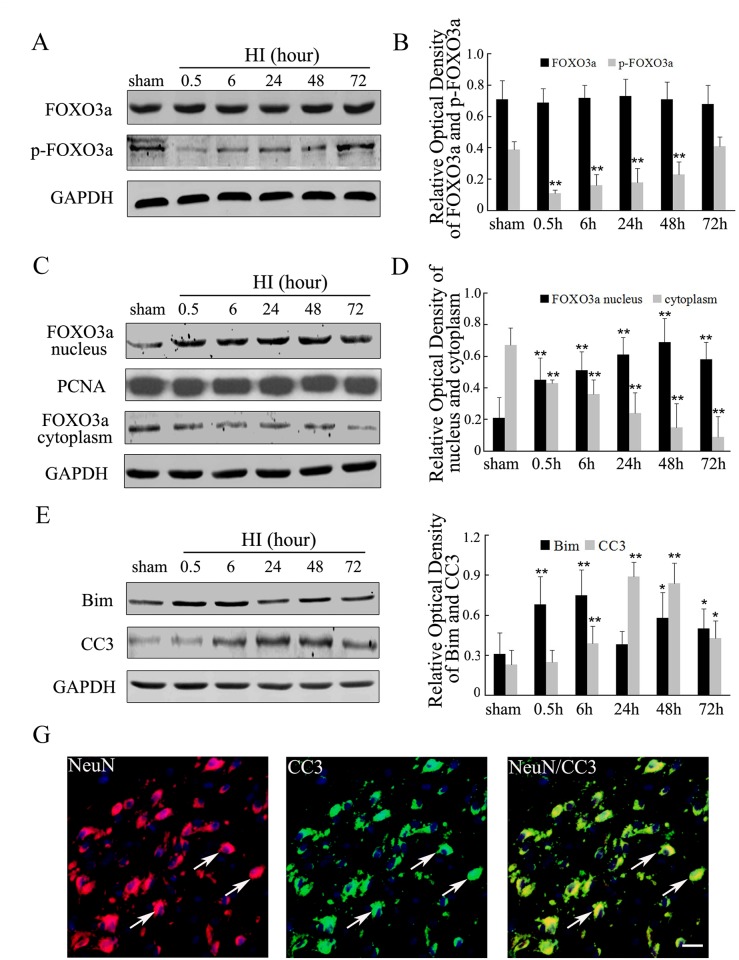
HI promotes FOXO3a dephosphorylation, which induces FOXO3a translocation into the nucleus and upregulates the expression of Bim and CC3.Samples were obtained from the cortex. Equal levels of protein samples (100 μg) were loaded, and GAPDH served as a loading control. The values are expressed as the relative optical density and represented as the mean±SD (n = 5). Total FOXO3a levels remained unchanged at the indicated time points (A). However, p-FOXO3a levels decreased from 0.5 to 48 h and returned to baseline at 72 h after HI (A). Nuclear FOXO3a protein levels obviously increased from 0.5 to 48 h in a time-dependent manner and remained at a high level at 72 h (C). In contrast, the cytoplasmic protein level decreased from 0.5 to 72 h (C). Bim protein was obviously induced at 0.5 h, peaked at 6 h, returned to baseline at 24 h, and then increased again at 48 h and lasted through to 72 h (E). CC3 protein was obviously induced at 6 h, peaked at 24 and 48 h, and remained at a high level at 72 h (E). Total FOXO3a, p-FOXO3a, nuclear and cytosolic proteins of FOXO3a, Bim and CC3 expression in the HI groups and sham controls were quantified. The data were obtained by densitometry and normalized to GAPDH. **p<0.01 compared with the sham control (B, D and F). (HI, hypoxia-ischemia). The cell type specificity of Bim with double fluorescent immunolabeling (n = 5). Bim and the neuronal specific marker NeuN were visualized using an anti-Bim antibody followed by a FITC-conjugated secondary antibody (green) and an anti-NeuN antibody followed by a TRITC-conjugated secondary antibody (red). The nucleus was stained with DAPI (blue). Bim (G) immunoreactivity colocalized to neurons (yellow) in the ischemic cortex. Scale bar, 50 μm.